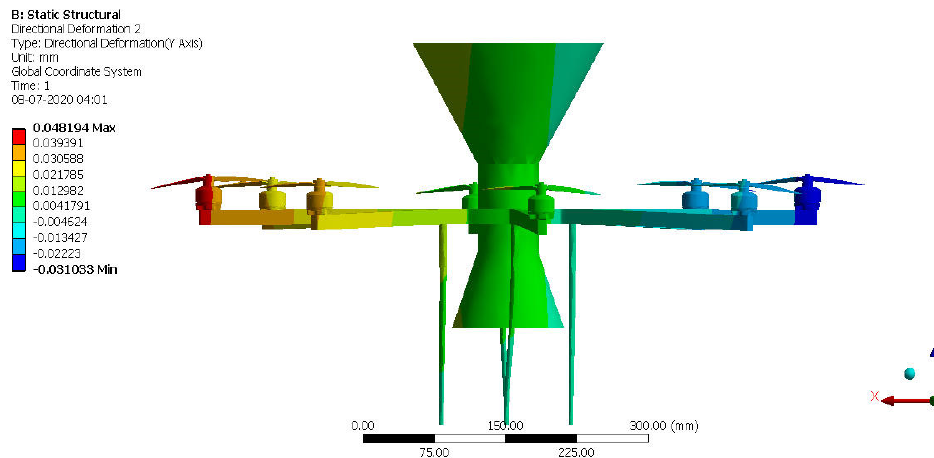
Figure 31. Variations of displacement in the Y direction.